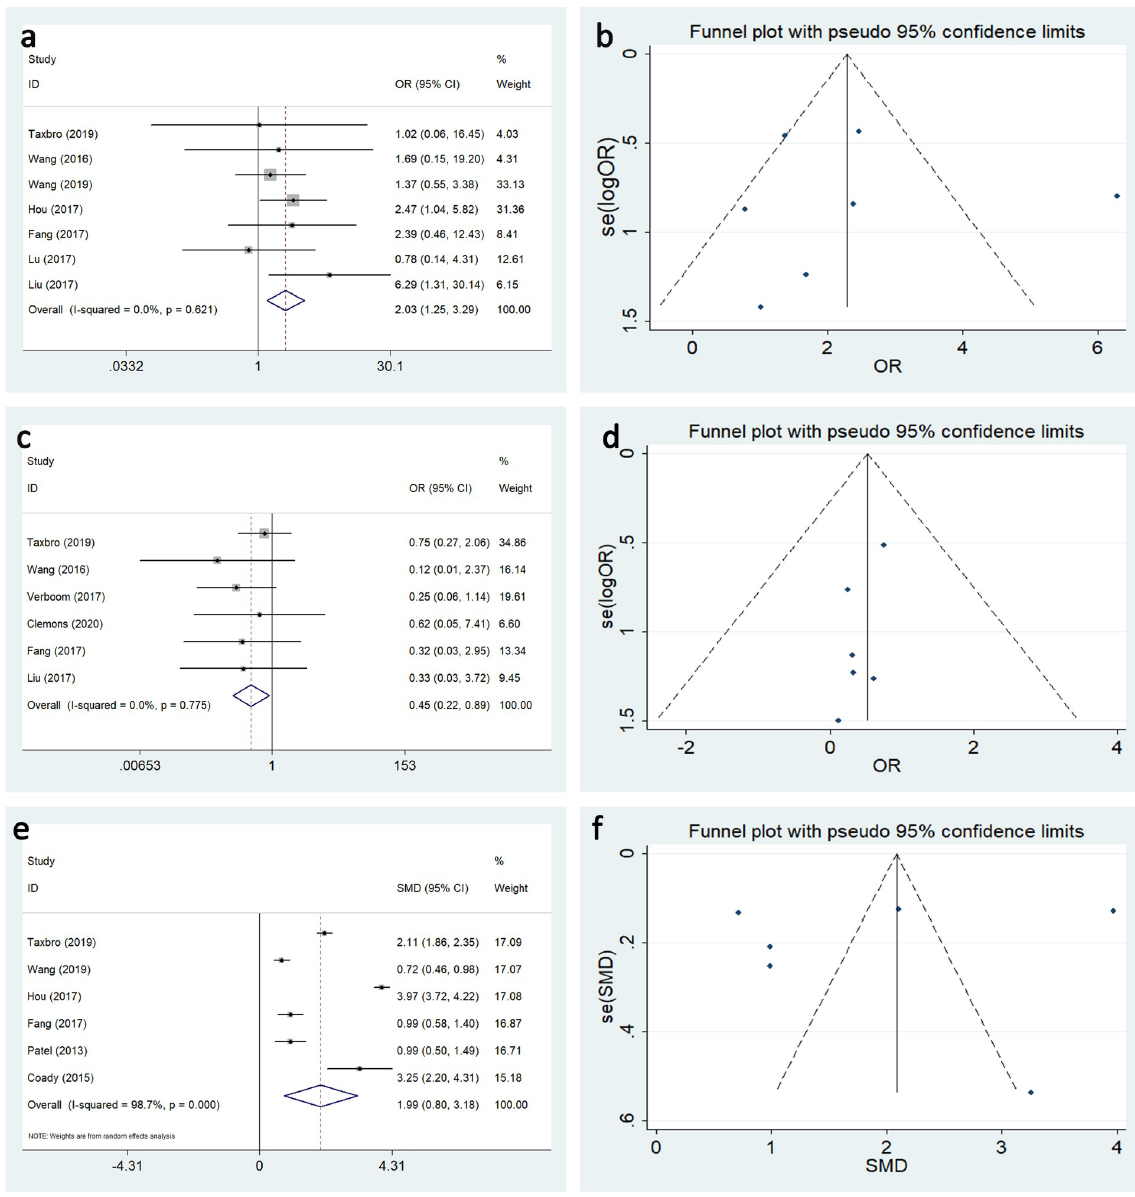
Fig 2. Forest plots and Funnel plots for publication bias test for the comparing data related to placement between TIVAP and PICC. (a and b) the first-puncture success rate, (c and d) the accidental removal rate, (e and f) catheter life span. indicated that TIVAP was associated with a lower infection rate compared with PICC (OR: 0.570, 95%CI:0.383–0.850, P = 0.006, I 2 = 64.9%) (Fig 3). Occlusion in the TIVAP group was significantly lower than in the PICC group (OR:0.172, 95%CI:0.092–0.324) (Fig 4A), and malposition (OR:0.279, 95%CI:0.128–0.608) (Fig 4B), thrombosis (OR:0.191, 95%CI:0.111–0.329) (Fig 4C), phlebitis (OR:0.102, 95%CI:0.038–0.273) (Fig 4E), and allergy (OR:0.155, 95%CI:0.035–0.696) (Fig 4F). However, there was no signifi- cant difference between the TIVAP and PICC groups with regard to extravasation (OR:0.510, 95%CI:0.130–1.997) (Fig 4D).